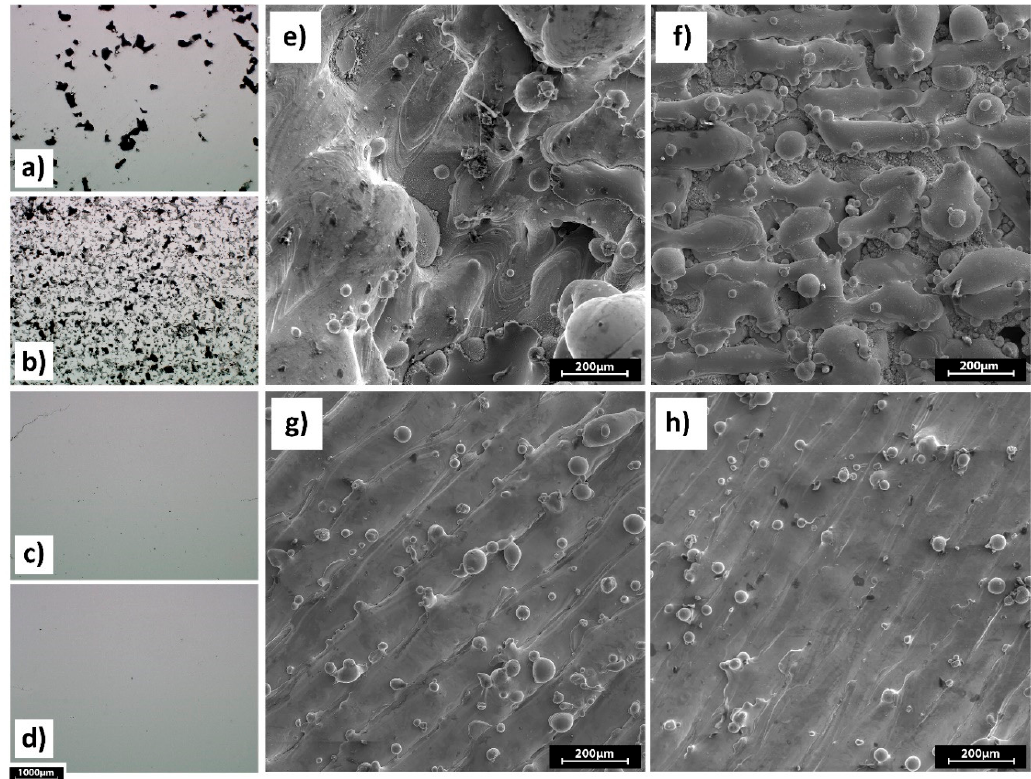
Figure 6. Effect of process parameters on the relative density of the samples, optical micrographs of the cross-sections: ( a ) Sample A2; ( b ) sample A10; ( c ) sample C10; and ( d ) sample C9. SEM micrographs of the top surfaces of samples: ( e ) Sample A2; ( f ) sample A10; ( g ) sample C10; and ( h ) sample C9 .